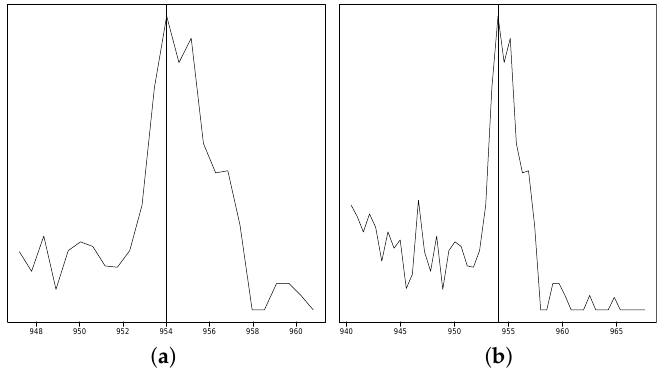
Figure 1. This figure exemplarily shows one out of the 255,000 peak plots that the experts evaluated. ( a ) The EIC in a ± 7 s retention time window. ( b ) The EIC in a ± 14 s retention time